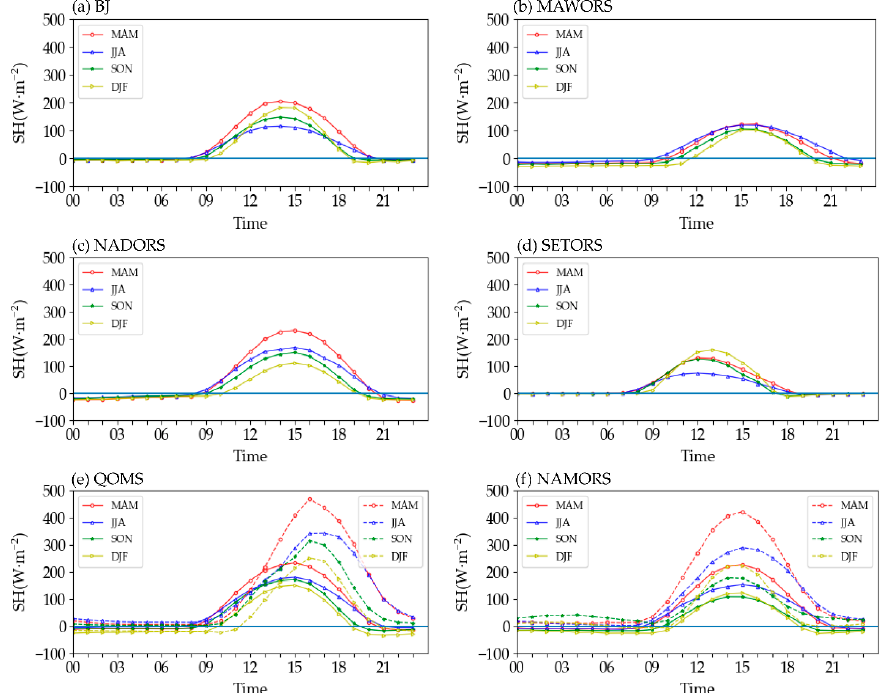
Figure 3. Climatological seasonal mean of the diurnal variation of the observed SH (solid lines, W m − 2 ) at ( a ) BJ, ( b ) MAWORS, ( c ) NADORS, ( d ) SETORS, ( e ) QOMS, and ( f ) NAMORS, and the calculated SH (dashed lines, W m − 2 ) at ( e ) QOMS and ( f ) NAMORS. In the past, due to the lack of flux observations over the TP region, most studies on SH were based on the calculated SH by using Equation (1) or reanalysis datasets [36,37], but uncertainties and biases always existed. The diurnal variations of the calculated SH and the observed SH at QOMS and NAMORS are also displayed in Figure 3e,f to detect the bias between them. We find that the diurnal variation of calculated SH shows similar seasonal distribution with the observed one, showing the greatest amplitude in spring and the smallest in winter at QOMS, and an abnormally stronger amplitude in winter at NAMORS. However, significant differences exist in the diurnal variation amplitude be- tween calculated SH and observed SH; that is, the former is about 64–100% larger than the latter, which suggests that the calculated SH over the TP used in previous studies may be largely overestimated. Additionally, the peak timing of the calculated SH also shows dif- ferent features compared with that of observed SH, mainly in that the latter is at 16:00, which is one hour later than the former at QOMS, suggesting that a significant phase shift occurs between the calculated SH and observed SH, while this phenomenon is not evident at NAMORS. 4. Monthly Changes of the SH Diurnal Variation over the TP In order to further understand the SH diurnal variation over the TP in detail, we need to shorten the time scale to obtain the monthly mean of the SH diurnal variation. 4.1. Monthly Changes of the Diurnal Variation in Observed SH Figure 4 shows the monthly mean of the diurnal variation of the observed SH. Obvi- ously, it can be seen that the diurnal amplitudes of the SH among stations are significantly different, with smaller values at MAWORS and SETORS and larger values at the other four stations, which is also consistent with the results in Section 3. Furthermore, the